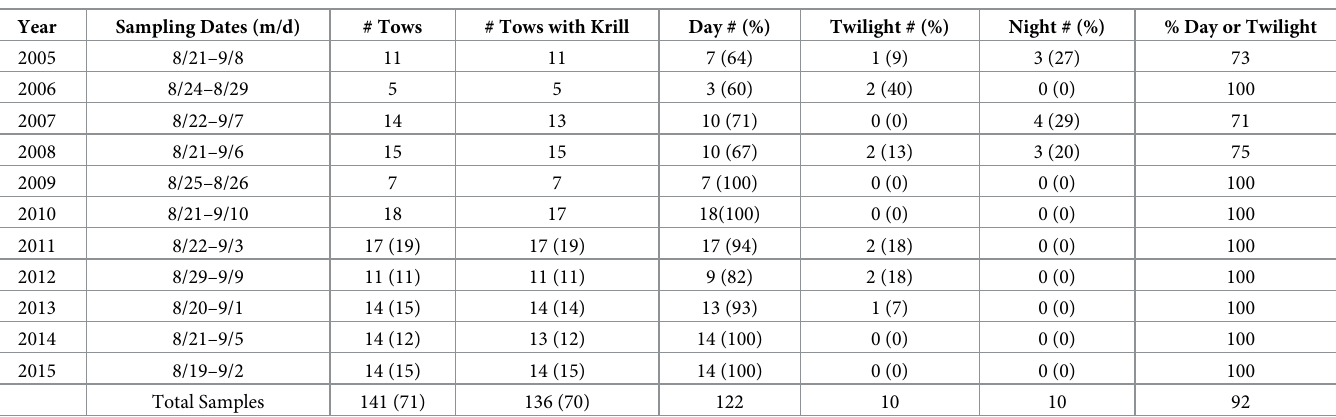
Table 1. Net tow information.